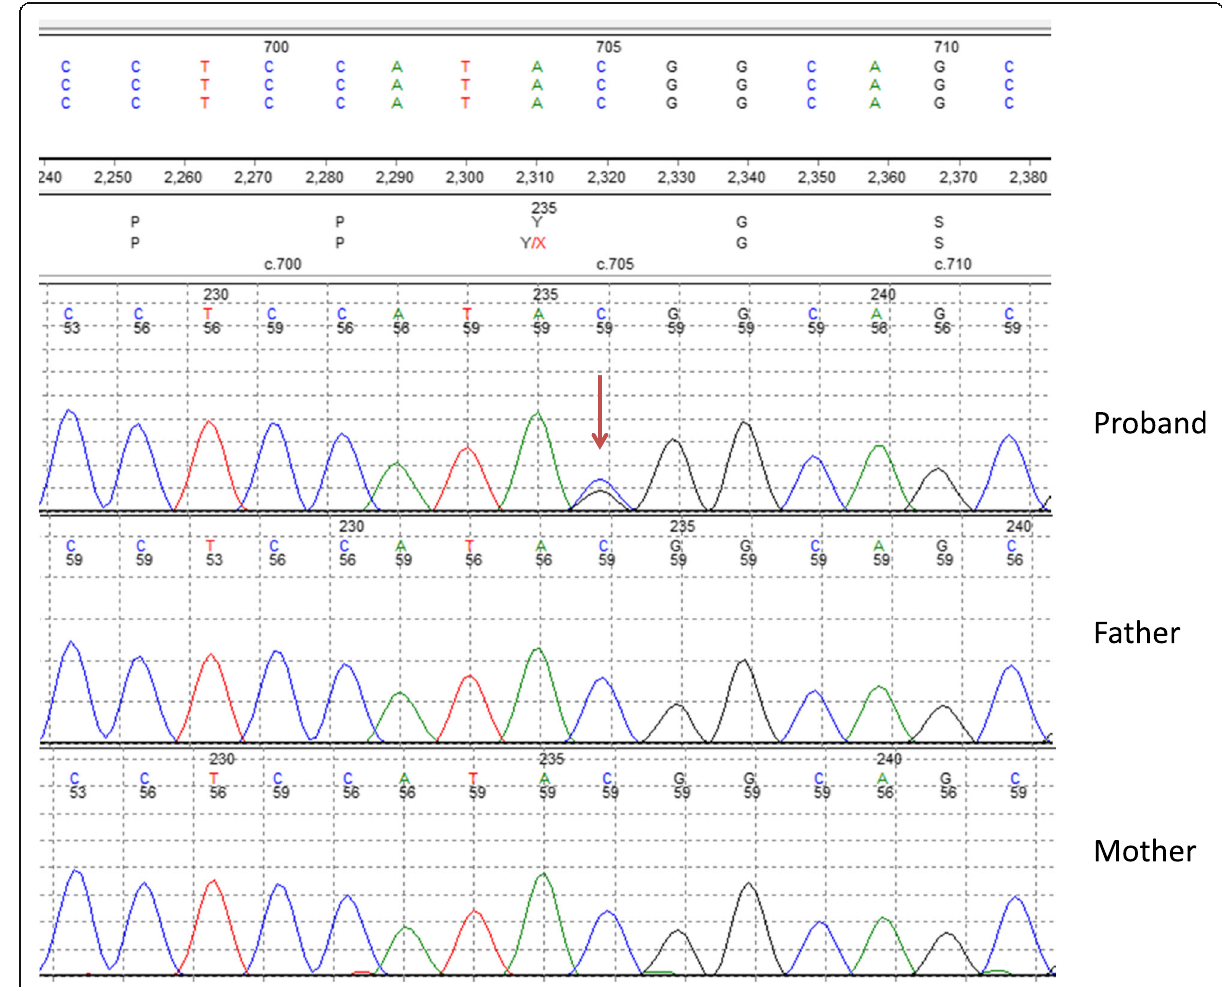
Fig. 3 Sanger sequencing electropherogram of GATA6 exon 2 showing the heterozygous C > G single base substitution at nucleotide position 705 (c.705C > G) resulting the nonsense variant (p.Tyr235Ter) in the proband. The variant is absent in electropherograms from mother and father. Sanger sequencing is able to detect low level somatic mosaicism to a level of approximately 5 –